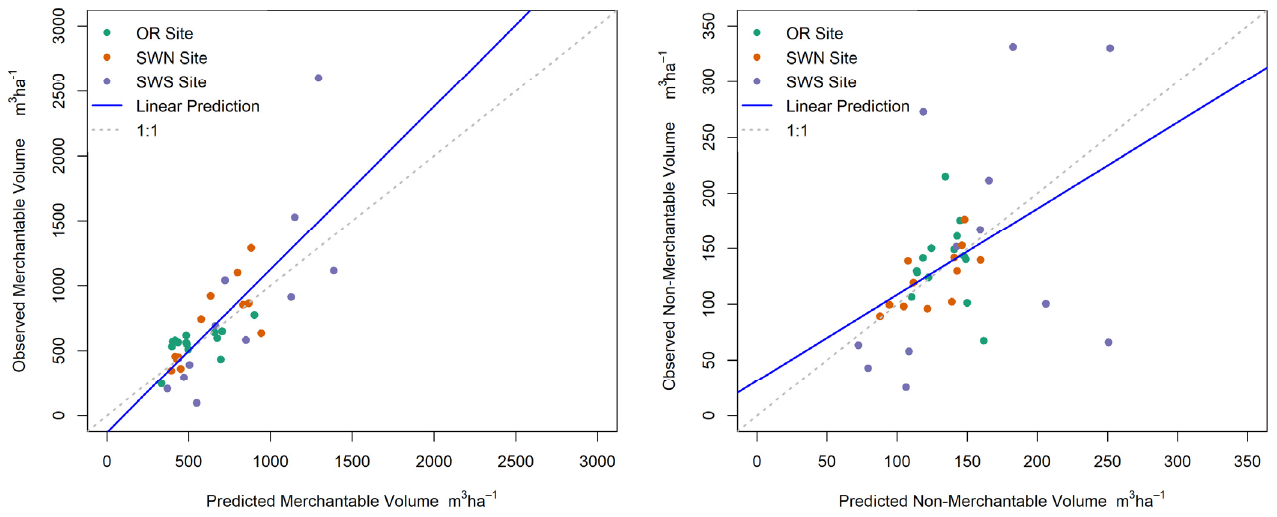
Figure 4. Observed plot level vs. RF predicted merchantable ( left ) and non-merchantable ( right ) volumes at the Oyster River (OR) (green), Sooke Lake Watershed South (SWS) (purple), and Sooke Lake Watershed North (SWN) (orange) sites. Table 4. Block digitized areas (ha) and block-level HB random forest model estimates of merchant-